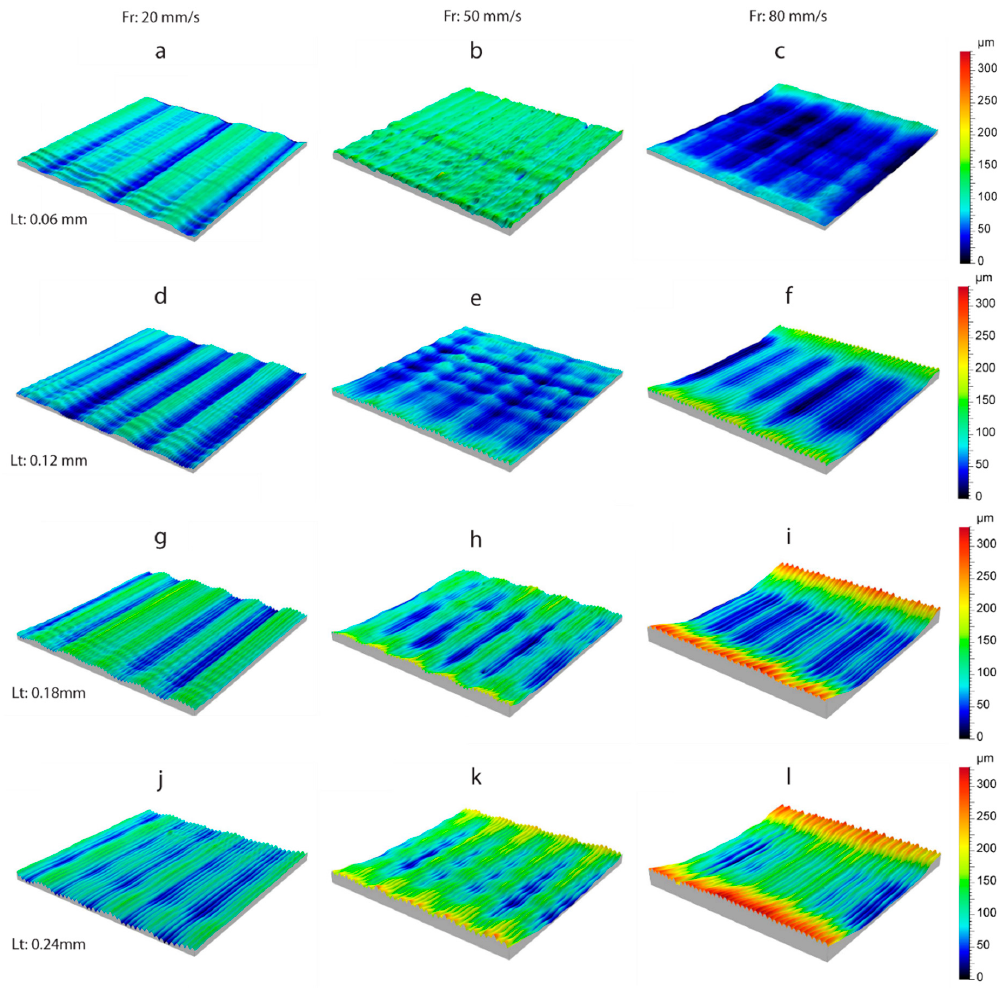
= 0.06 mm, Fr = 20 mm / s;